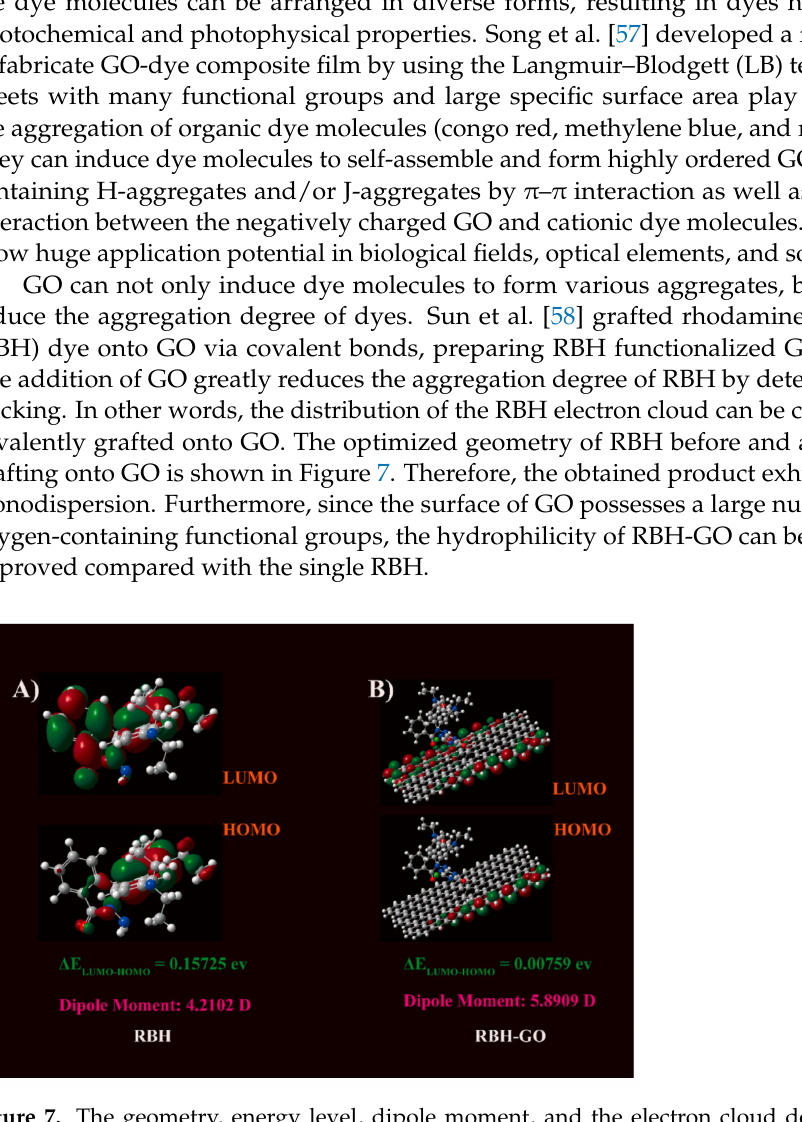
Figure 7. The geometry, energy level, dipole moment, and the electron cloud density distribu- tion of ( A ) RBH and ( B ) RBH-GO. (Reproduced with permission from ref. [58]. Copyright 2021 Elsevier